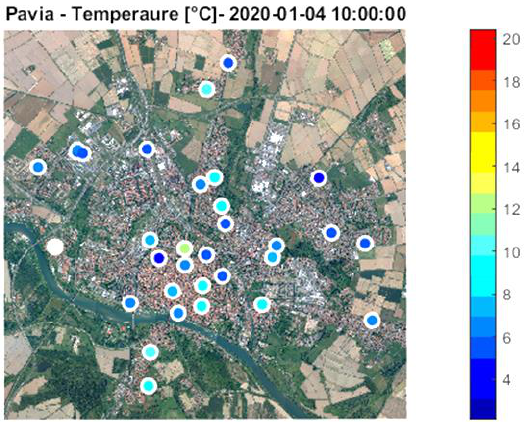
Figure 12. Color-coded measurements for temperature and all the monitors; day selected in January 4th, 2020 and time shown is 10:00 AM